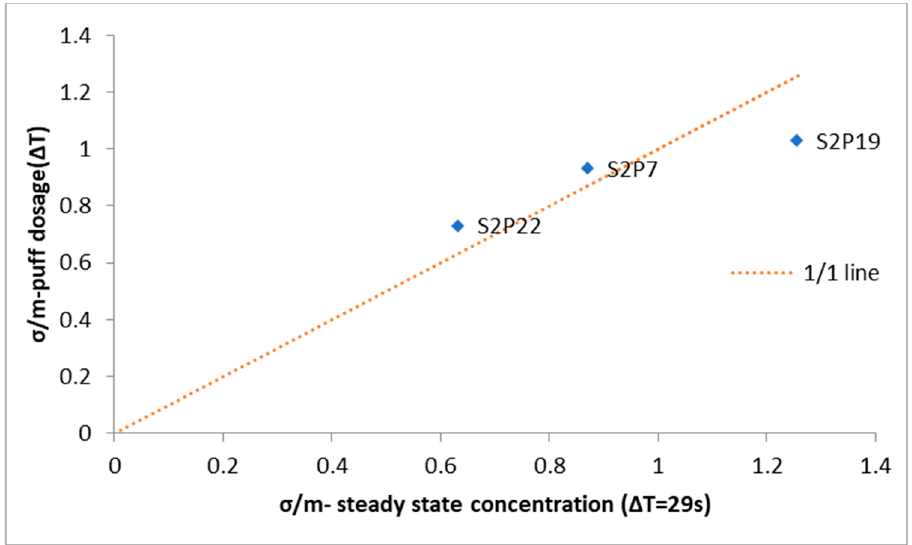
Figure 4. Puff release vs. continuous release intercomparisons: (cid:2026)/(cid:1865) ratios It is shown that the correlation between the steady state and the puff releases (cid:2026) (cid:1865)⁄ ratios is quite good and close to unity.